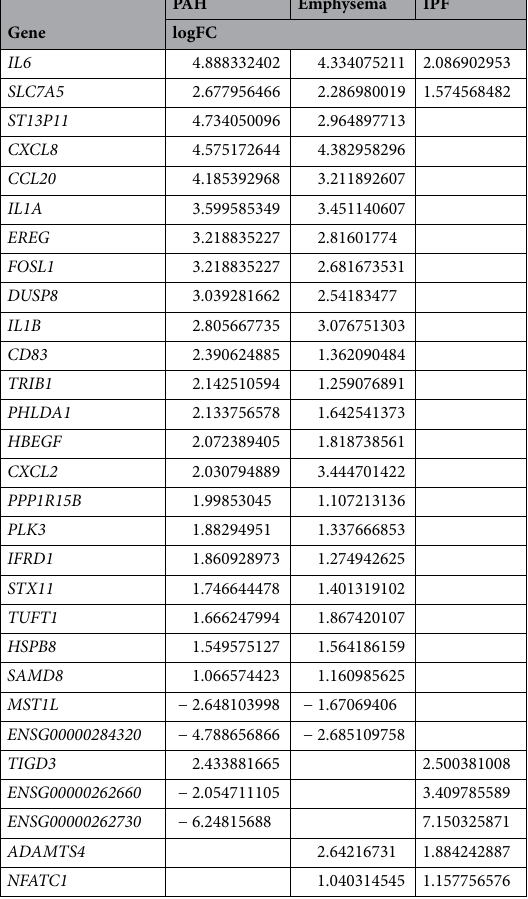
Table 3. Fold change of genes changed with EVLP (T6 vs .